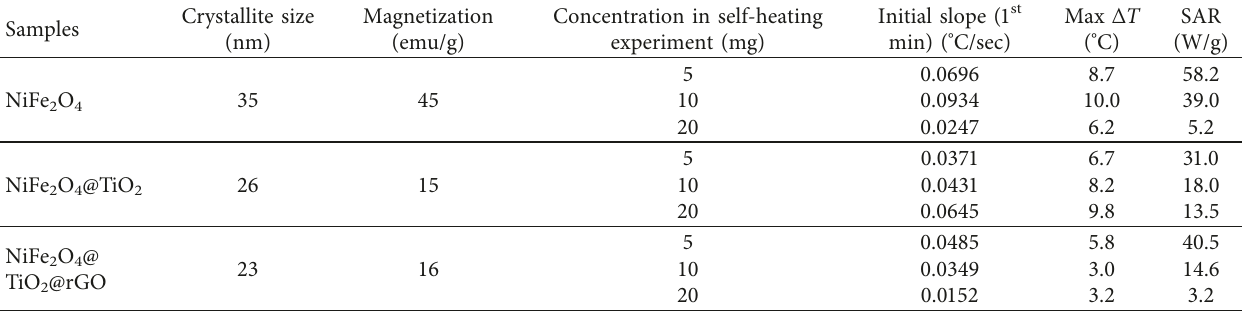
Table 3: Hyperthermia heat efficiency and SAR value of core@shell nanoparticles. Samples